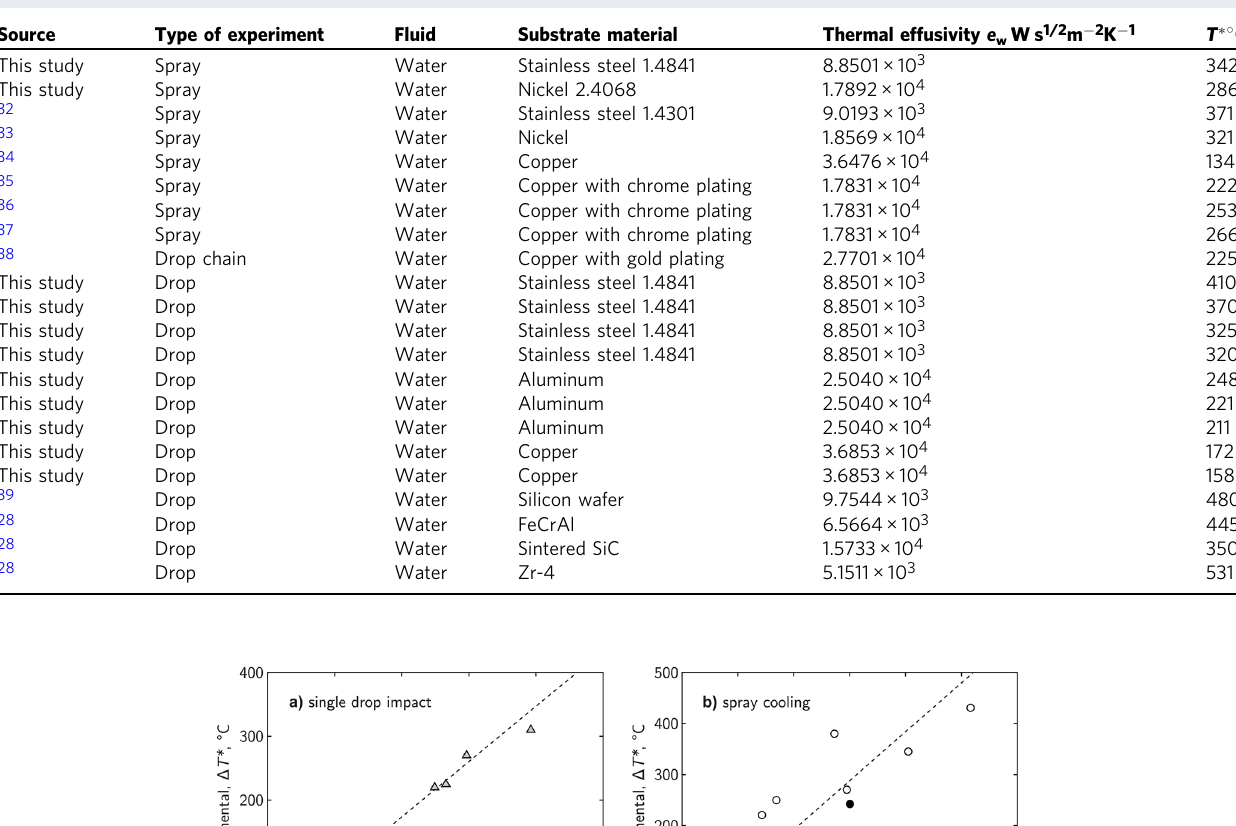
Table 1 List of the liquid and substrate materials and the values of the threshold temperature T * .